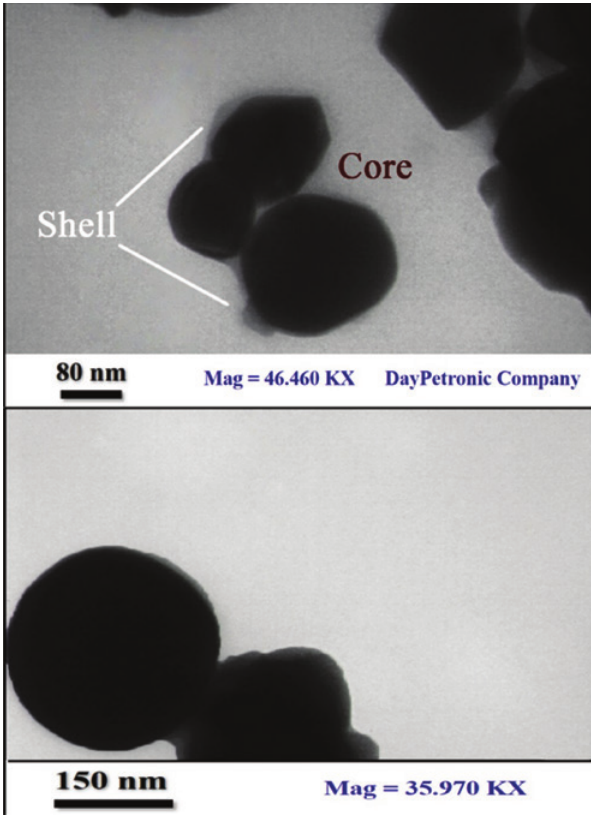
Figure 11: The TEM images of the PbFe